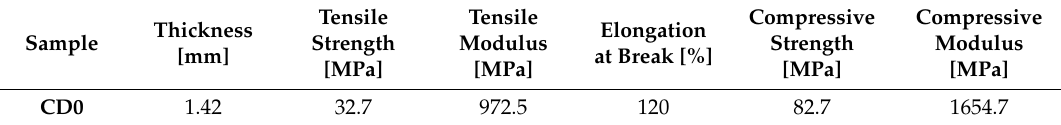
Table 2. Mechanical properties of a compact disc [28].